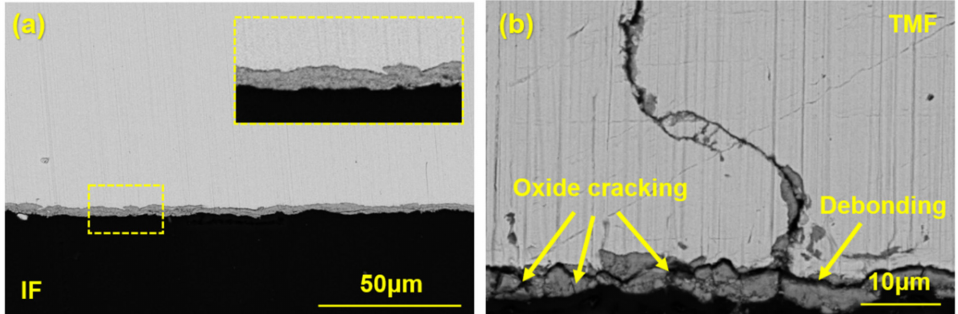
Figure 5. The morphologies of surface oxide scales under conditions of ( a ) IF and ( b ) TMF